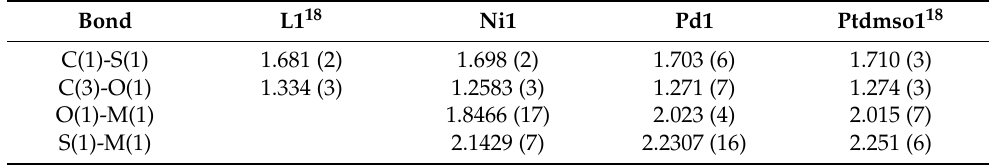
Table 3. Specific bond lengths [Å] for 1 compounds; data from L1 and PtDMSO1 are reproduced from [18] with permission of the Royal Society of